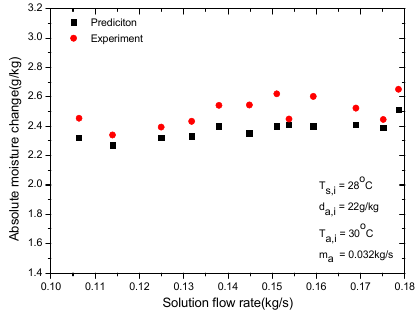
Figure 7. Influence of solution flow rate on dehumidification performance.